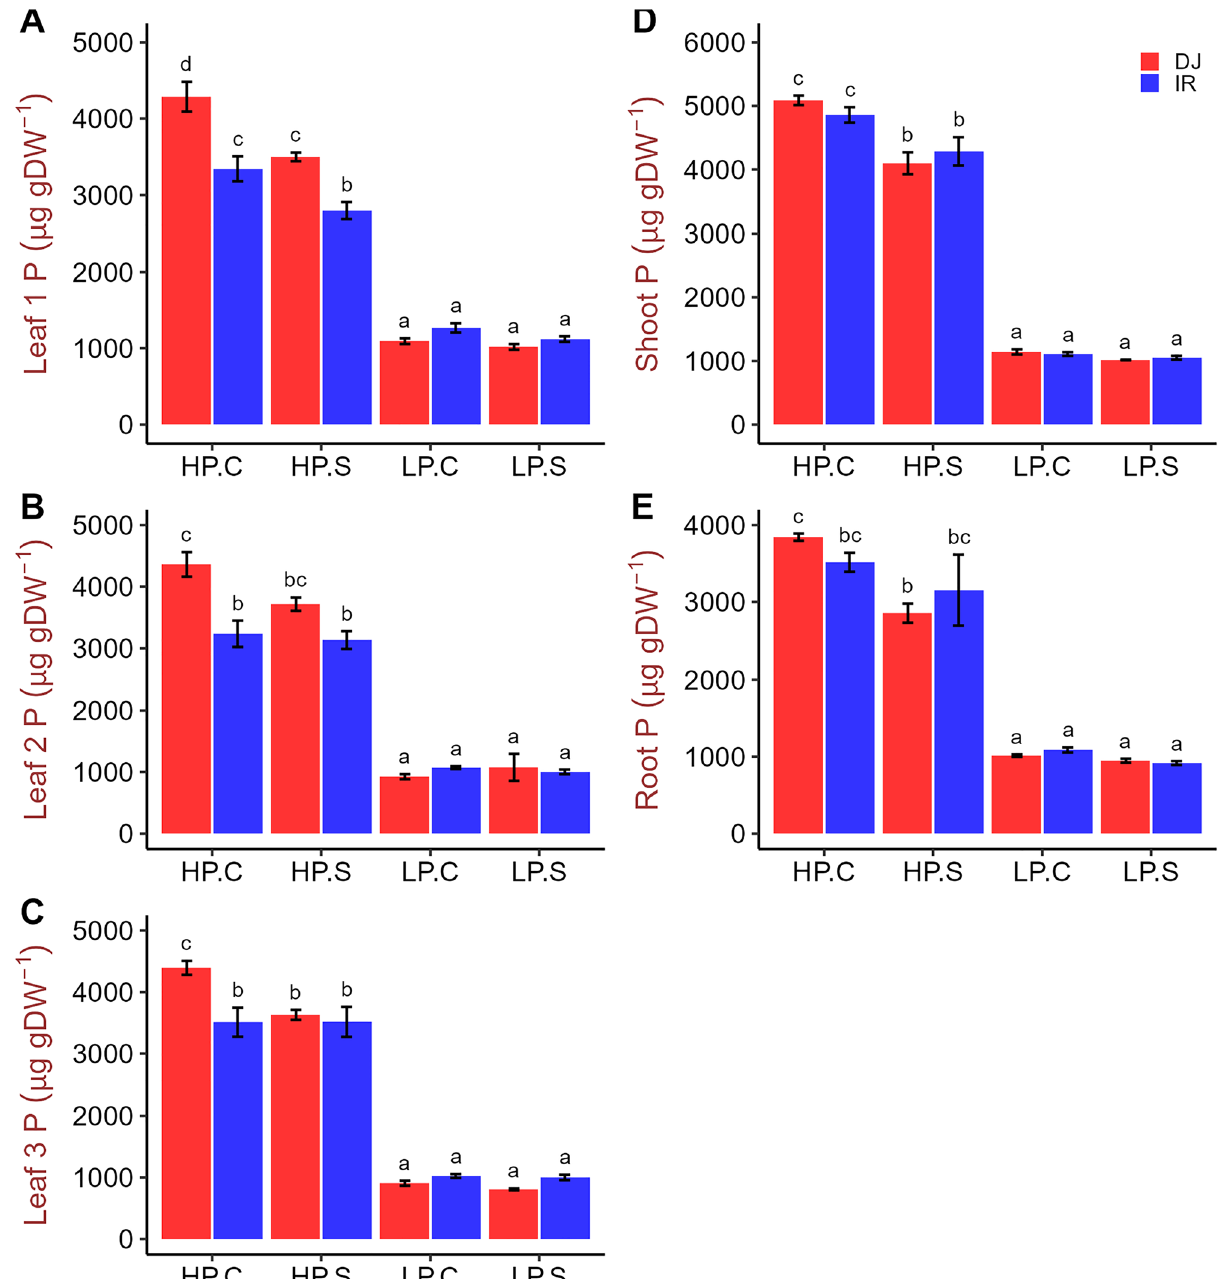
Figure 3. Phosphorus concentration in different tissues of DJ123 and IR64 grown under varying phosphorus supply. Data are the mean ± SE of four independent replicates. ‘HP’ and ‘LP’ stand for high- and low-phosphorus supply, respectively. Plants were grown on HP and LP treatments for 40 days after germination. Then, both groups were splitted into two sub-groups. Phosphorus supply was continued as usual for one sub-group of each treatment (labelled as ‘C’) and stopped for the other group (labelled as ‘S’). After approximately 24 and 48 h, LP and HP sub-groups were harvested, respectively. Significant differences among treatments were determined by ‘generalised least square’ model, separated by Tukey’s test (P < 0.05), and are indicated by different seen for the global gene expression patterns in leaf samples, where P treatments explained 47–49% (Fig. 5F,G) of the variance within each genotype. The main difference between expression patterns in root and shoot samples is the very clear separation by high versus low P supply in shoots (Fig. 5E,F), whereas this separation was less distinct in roots (Fig. 5B), especially in DJ123 (Fig. 5C) where HPS-treated roots appeared to be in between HPC and both low-P treatments. The shift of the HPS-treated root transcriptomes towards the LP-treated ones might suggest that the former has already responded to the 48 h of P deficiency in the growing medium, especially in DJ123. Based on these observations, we hypothesized that DJ123 responded faster to the short-term P deficiency